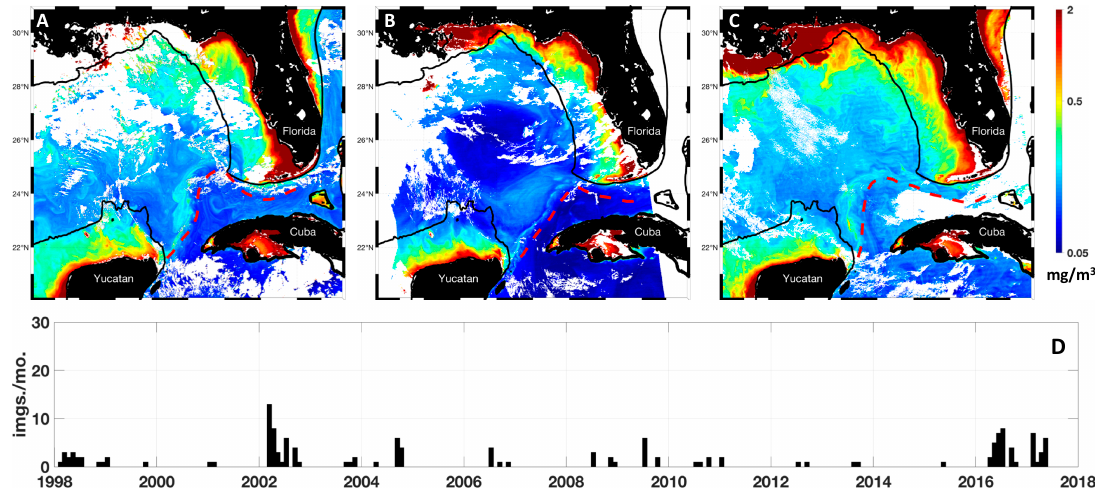
Figure 3. SeaWiFS and MODIS-Aqua chlorophyll-a images showing transport of water from the Campeche Bank to the Florida Keys. From left, ( A ) SeaWiFS image from 14 March 2002, ( B ) MODIS-Aqua image from 21 May 2016, and ( C ) MODIS-Aqua image from 10 February 2017. ( D ) Time series of the number of images per month which showed evidence of transport from Campeche Bank to the Florida Straits. Solid black line represents the 100 m isobath. Dashed red line represents the contour of the Loop Current estimated from altimetry derived MADT data for the date of the corresponding satellite image.